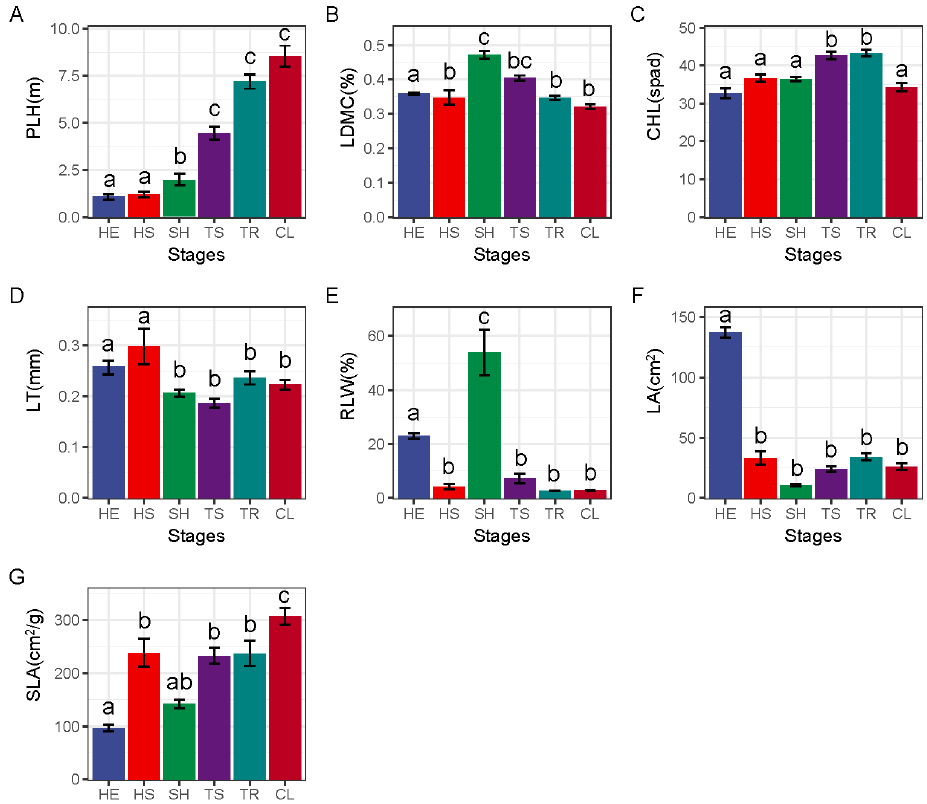
Figure 2. Weighted functional trait characteristics of communities at different restoration stages.